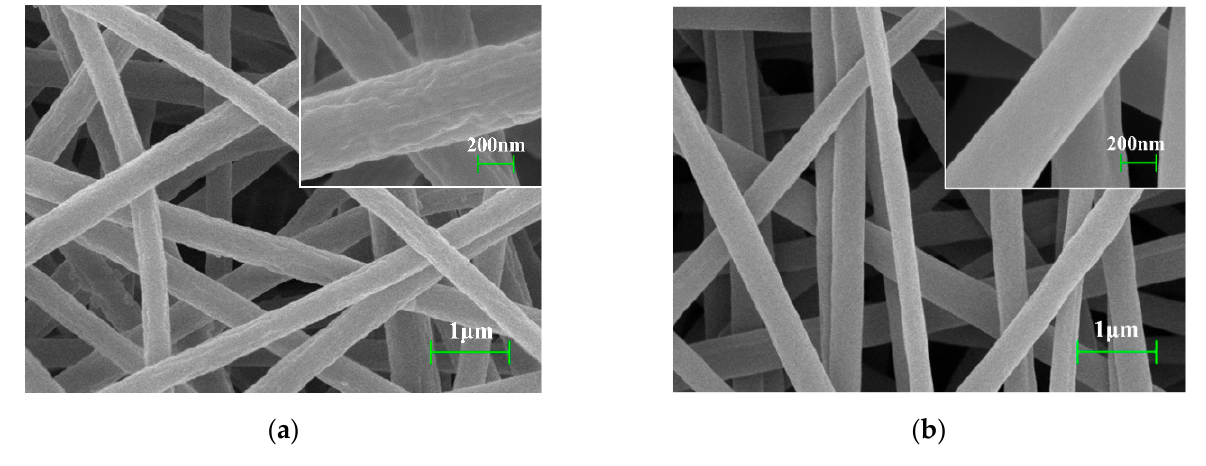
Figure 2. SEM images of ( a ) electrospun nanofibers (2.5 wt% PTA) and ( b ) carbonized nanofibers (ECNFM-2.5%-1000).